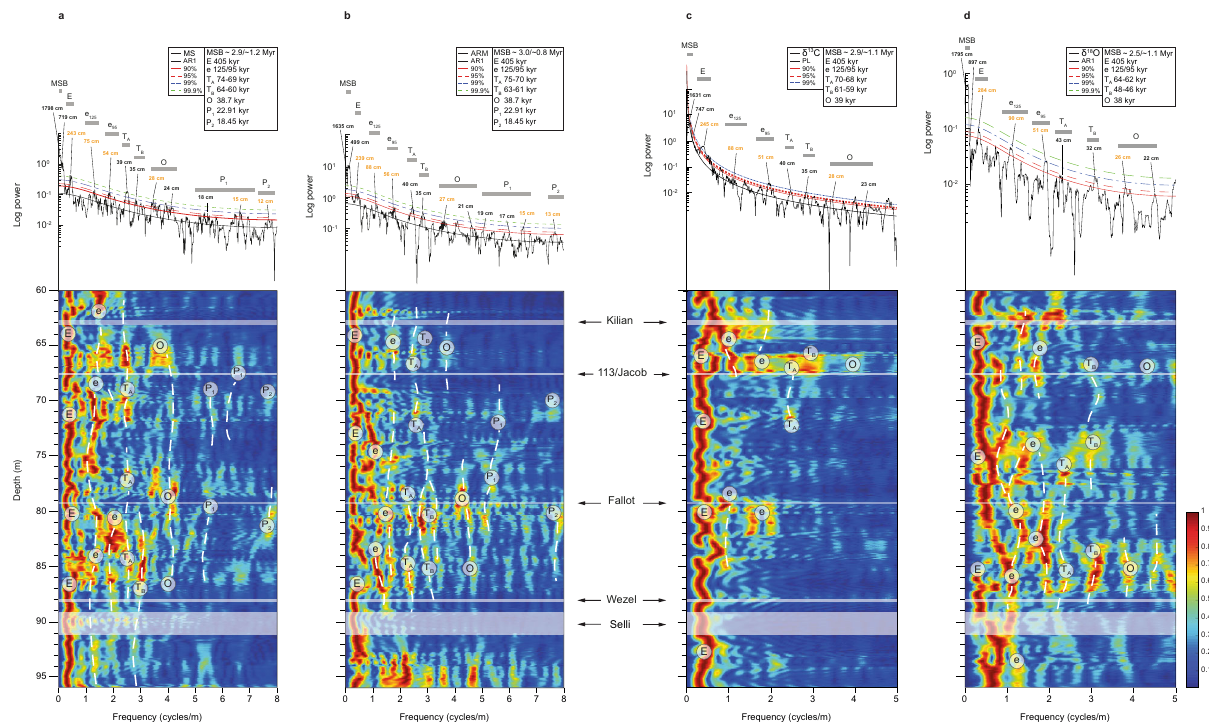
Fig. 3 Spectral analysis of the cyclostratigraphic series. a Magnetic susceptibility (MS); b anhysteretic remanent magnetization (ARM); c δ 13 C; d δ 18 O. Top: 2 π multitaper power spectra, with the AR(1) red noise spectral model and 90%, 95%, 99%, and 99,9% con fi dence levels (c.l.) for null hypothesis testing. Wavelengths of spectral peaks are labeled in cm. Bottom: evolutionary fast Fourier transform (eFFT) spectrograms with a 4 m sliding window, with each calculated eFFT spectrum normalized to 1. MSB million-year scale band, E long eccentricity, e 125 and e 95 125-kyr and 95-kyr short eccentricity, T A and T B are referred to periodicities of ~60 – 70 kyr, O obliquity, P 1 and P 2 89.34 m. In the stratigraphic interval 88.00 – 79.37 m, δ 18 O values oscillate between − 3.10 and − 1.30 ‰ , with two peaks at 85.75 m and 80.90 m ( − 3.88 ‰ and − 3.30 ‰ , respectively). Above